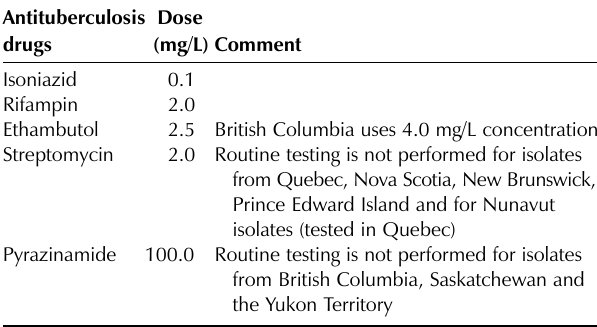
Concentrations for routine testing of first-line antituberculosis